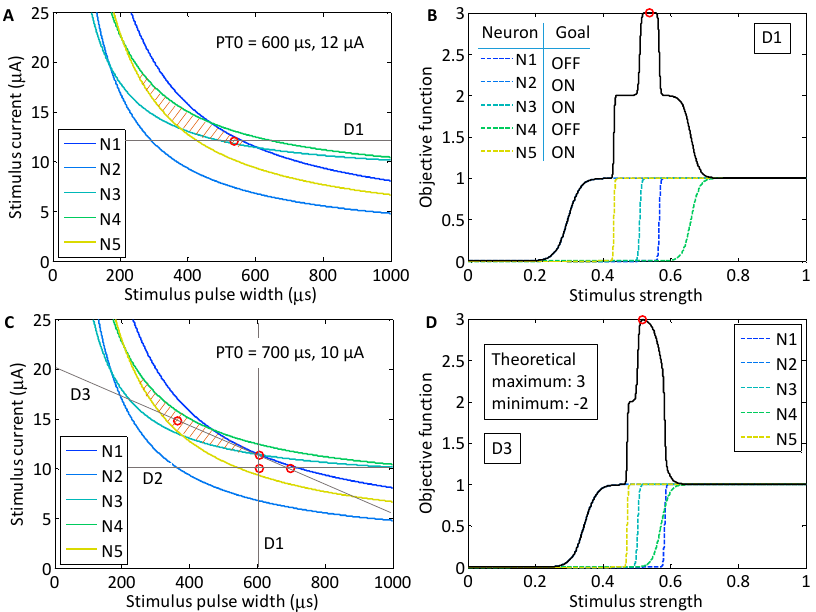
Figure 8. Two simulation studies were performed to find the selective region for the subpopulation of neurons including neuron N2, N3 and N5. ( A ) The selective region is highlighted with stripes. For the first study, a horizontal search through the starting point, PT0 (600 µ s, 12.0 µ A) yielded the theoretical maximum of the objective function (open red circle at 535 µ s, 12.0 µ A); ( B ) the objective function value is plotted along the first line search, D1. The individual neuronal activation sigmoids are plotted alongside the objective function (dotted lines). The first three target neurons activated before the off-target neurons activated; ( C ) The output from the second stimulation study, in which the starting point, PT0, was shifted to 700 µ s and 10.0 µ A; ( D ) After the 3rd line search, the theoretical maximum was found for the objective